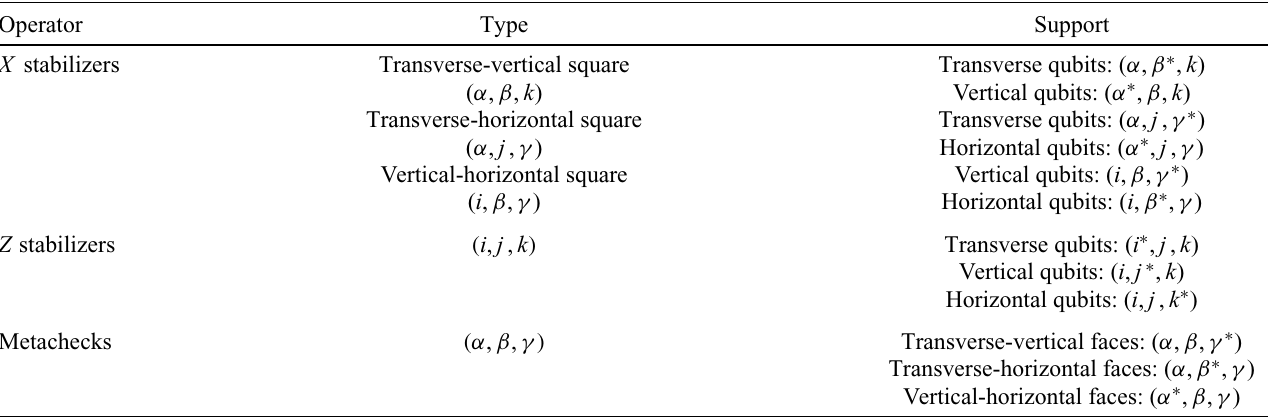
TABLE VI. Correspondence between operators of the chain complex ( C (cid:11)(cid:11)(cid:11) ), their type as geometric objects on the lattice, and their support. Note that the support of X and Z stabilizers is a set of qubits and edges while the support of metachecks is a set of X stabilizers and